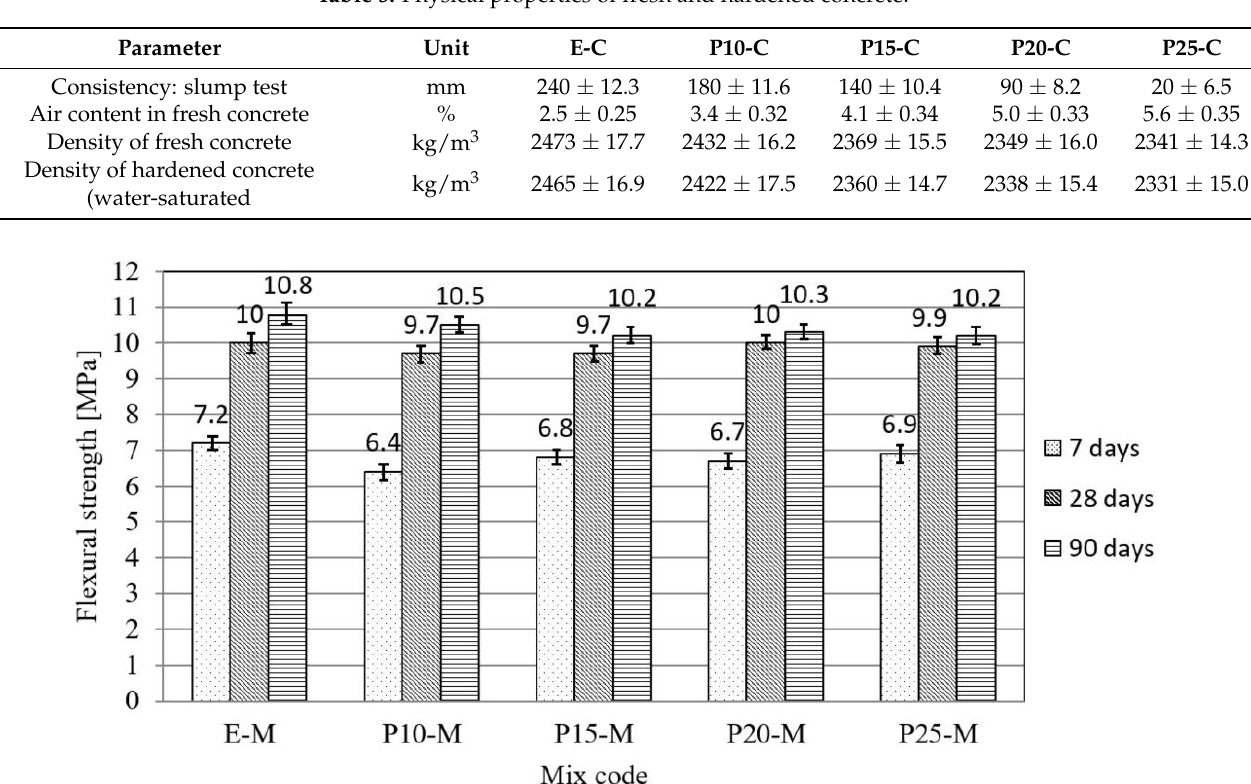
Figure 1. Flexural strength of mortar mixtures.